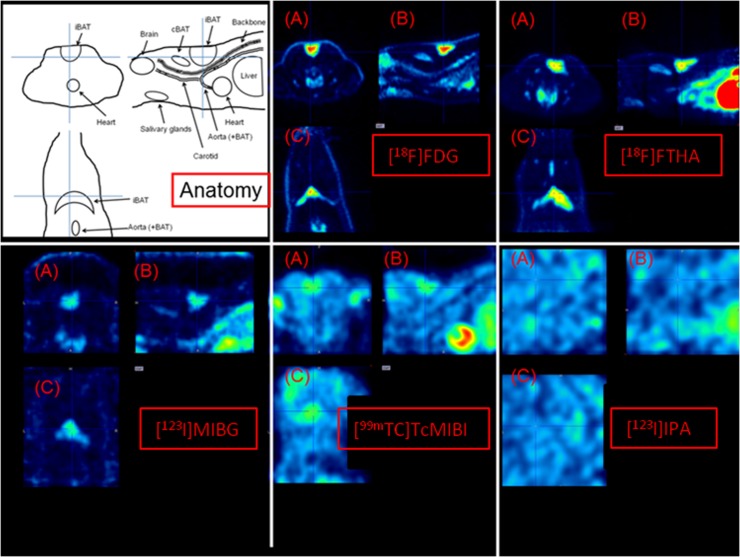
Transverse (A), sagittal (B) and coronal (C) slices of images from a cold-acclimated rat, centered on iBAT, depicting the anatomy, [18F]FDG distribution, [18F]FTHA distribution, [123I]MIBG distribution, [99mTc]TcMIBI and [123I]IPA distribution. iBAT, and to some extent cBAT show a high uptake for all tracers except [123I]IPA.